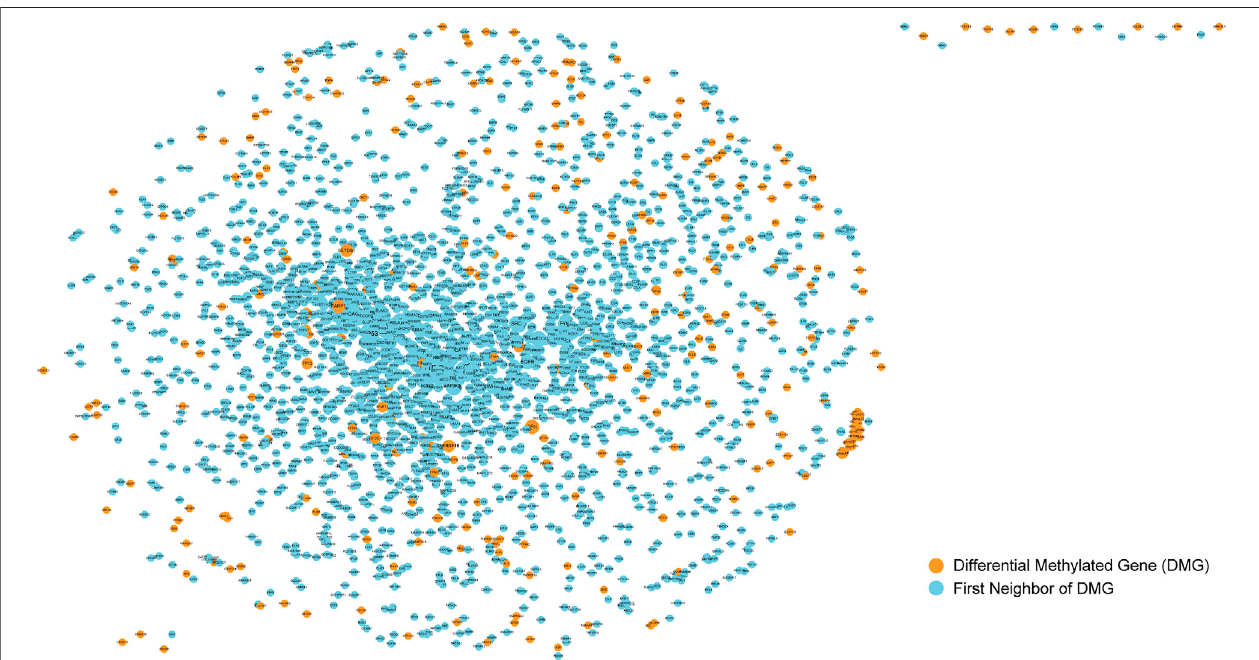
FIGURE 2 | Sub-network of protein-protein interaction network. The nodes colored orange represents the differential methylated genes, and the fi rst neighbors of them were represented by blue nodes.